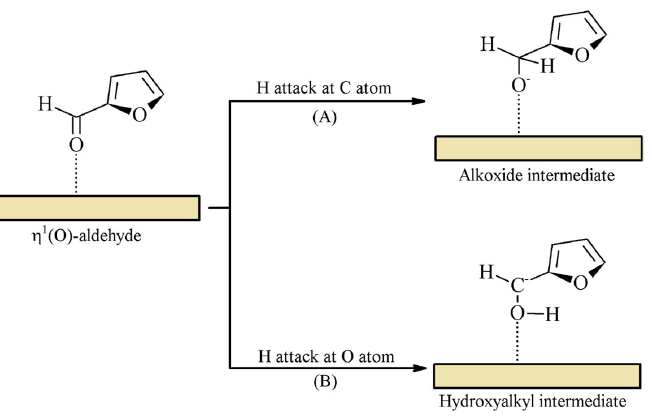
Figure 1. Orientation of FUR molecule on metal surfaces via formation of η 1 (O) ‐ aldehyde species. From the DFT data, Sitthisa et al. predicted that, after the interaction of Cu sites with FUR via η 1 (O), the reaction can proceed through two possible pathways, where H, coming from H 2 dissociation, can attack (i) the carbon of the carbonyl group, to generate an alkox ‐ ide intermediate, and (ii) the oxygen of the carbonyl group, leading to hydroxyalkyl spe ‐ cies [55]. Nevertheless, the formation of the hydroxyalkyl intermediate is favored due to